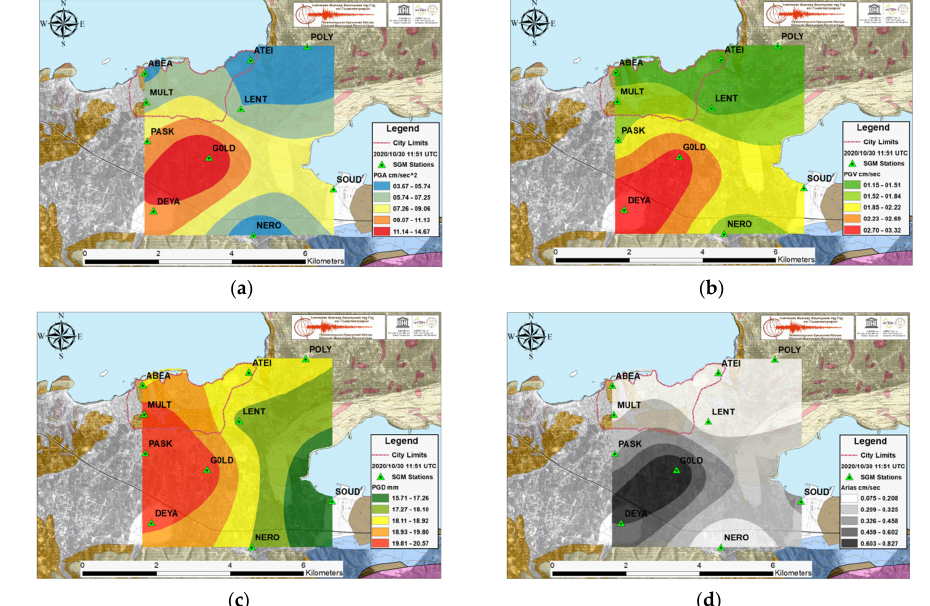
Figure 6. For the EQ.7 Samos strong event, Northeast of Chania, ground motion parameter spatial distribution results obtained from Ordinary Co-Kriging: ( a ) Peak Ground Acceleration in cm/s 2 ; ( b ) Peak Ground Velocity in cm/s; ( c ) Peak Ground Displacement in mm and ( d ) Arias Intensity in cm/sec. PERI-station was offline.